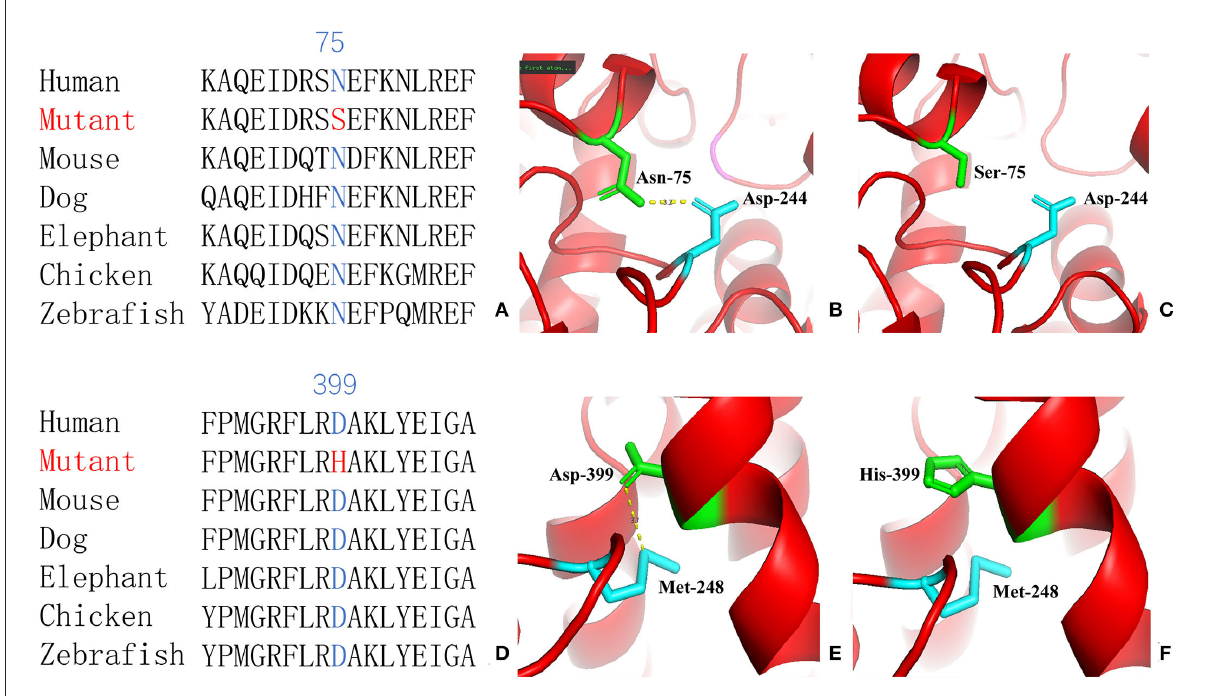
FIGURE4 Conservation of the identified amino acids across diverse species (A, D) and the 3D modeling for the IVD -wild and identified missense variant of site 75 (B, C) and site 399 (E, F) in our patient with isovaleric acidaemia